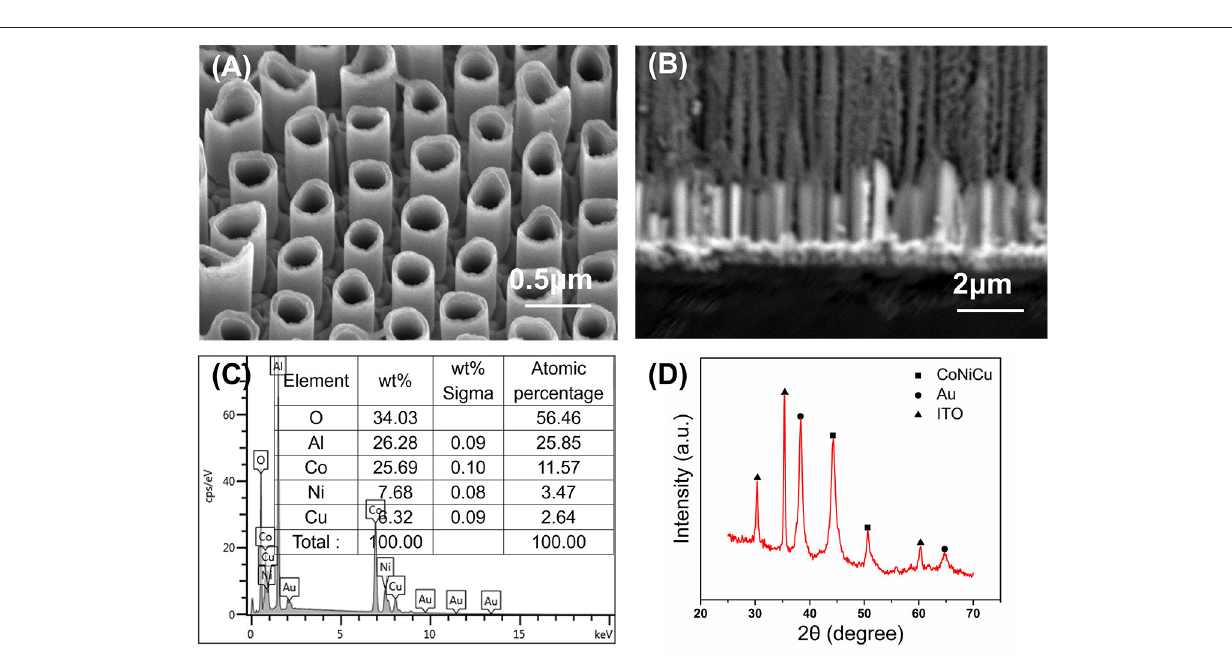
originate from the AAO temple. The crystal phase of CoNiCu nanotubes was further confirmed by XRD. The XRD patterns ( Figure 3D ) indicate that the nanotubes are of high